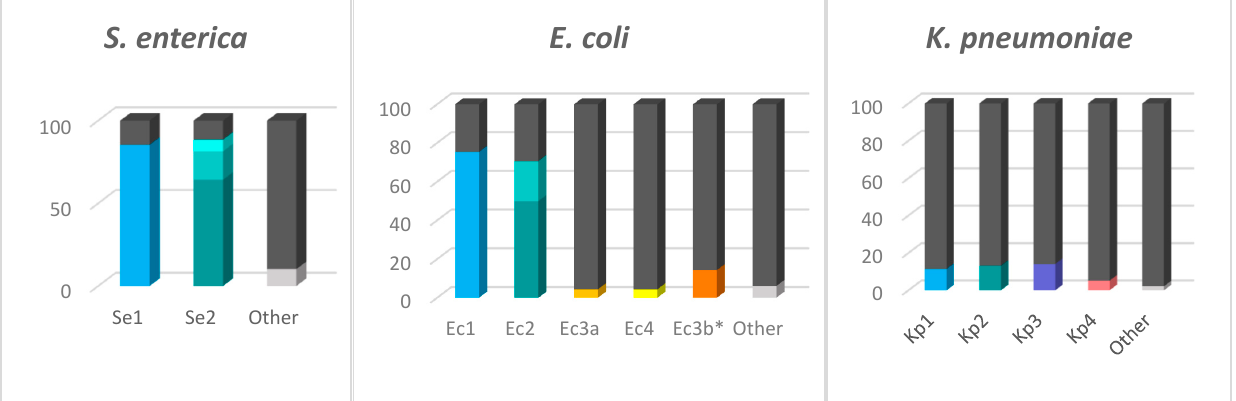
Figure 3. Genomes containing the CRISPR loci. The bars represent the total number of genomes